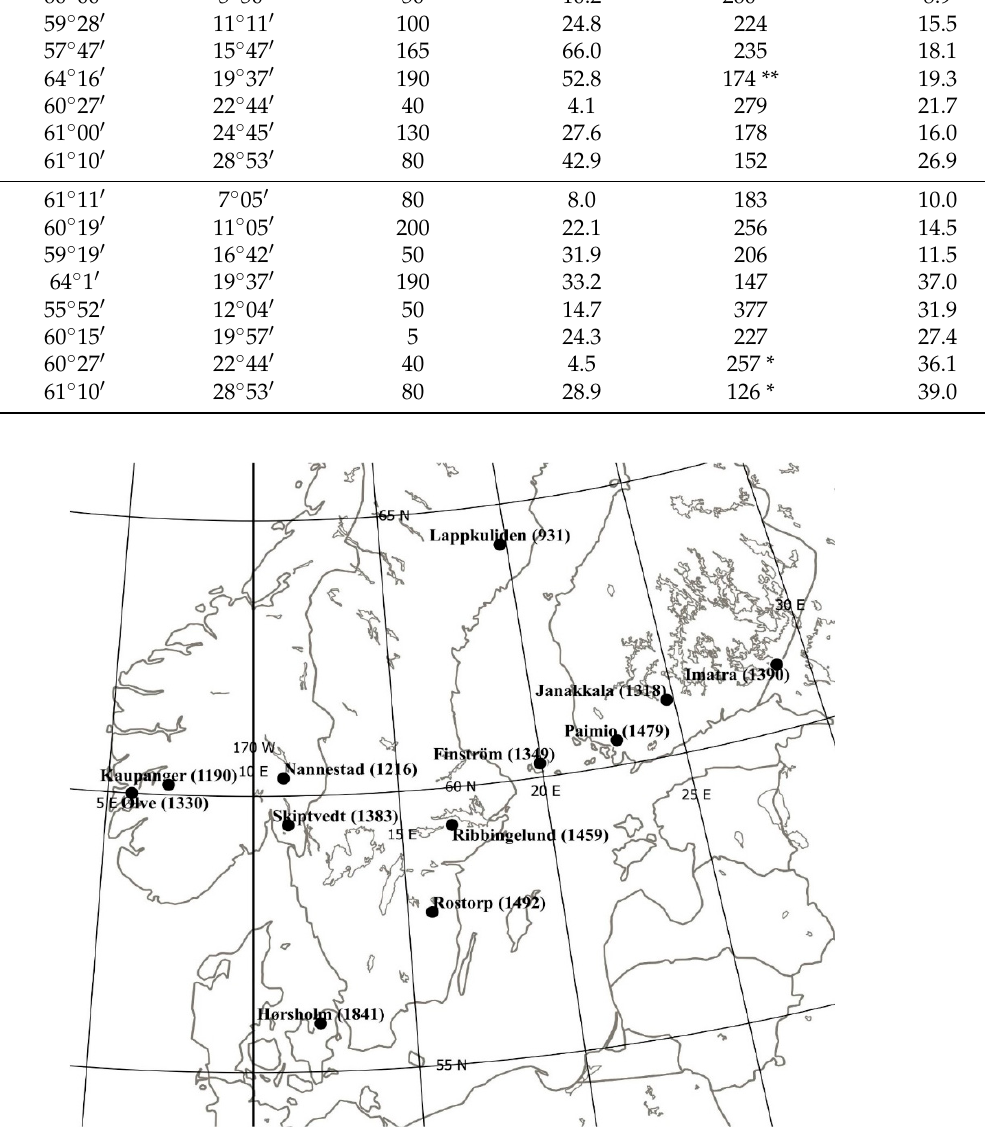
Figure 1. The field test sites in four Nordic countries with the annual temperature sum for mean daily temperature above 5 °C in brackets.